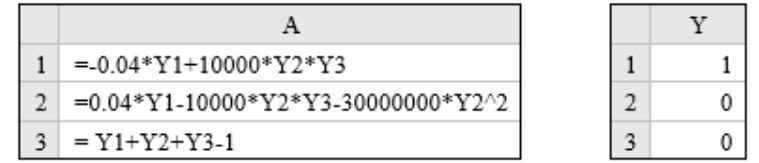
Figure A1 . Spreadsheet model for equation system (A2).